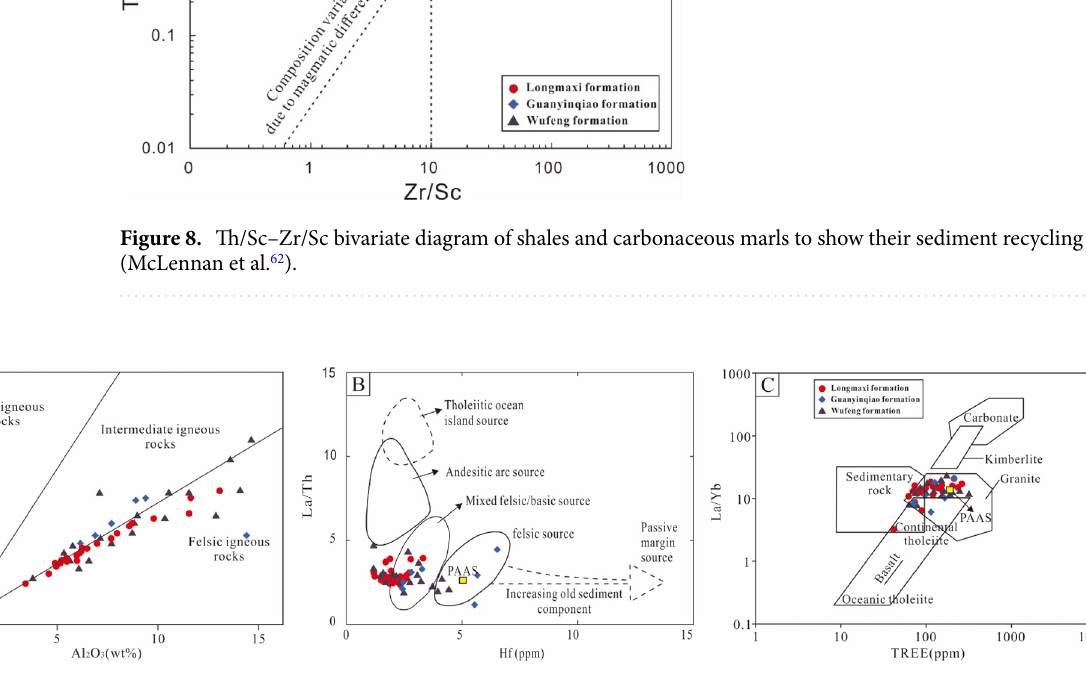
Figure 9. Provenance identification plots for the studied samples. ( A ) Al 2 O 3 vs. TiO 2 (after Hayashi et al. 69 ); ( B ) La/Th vs. Hf (after Floyd and Leveridge 67 ); ( C ) La/Yb vs ∑REE (after Roser and Korsch 68 ).